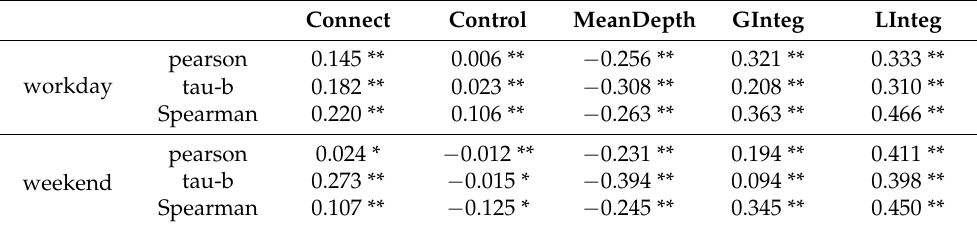
Table 3. Correlation of Spatial Syntactic Variables With Vitality.